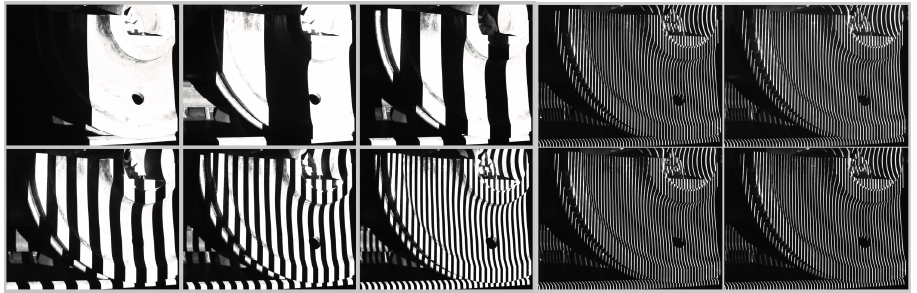
Figure 11. Coded image and light strip image captured by 3D scanning sensor at the first position.